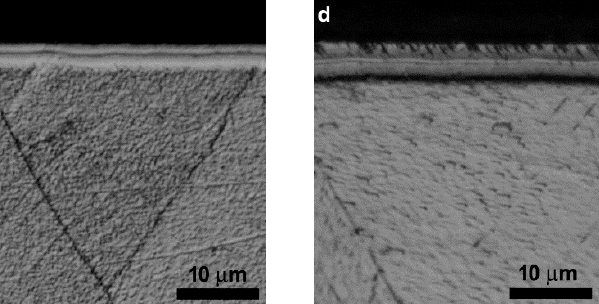
Figure 3. X-ray diffraction patterns of samples nitrided at 380 °C, for 3 h, using the following treat- ment atmospheres: 50 vol.% N 2 + 50 vol.% H 2 ( a ), 40 vol.% N 2 + 60 vol.% H 2 ( b ), 40 vol.% N 2 + 50 vol.% H 2 + 10 vol.% Ar ( c ), 30 vol.% N 2 + 50 vol.% H 2 + 20 vol.% Ar ( d ), 20 vol.% N 2 + 50 vol.% H 2 + 30 vol.% Ar ( e ). When nitriding was performed at 360 °C, with a gas mixture of 50 vol.% N 2 + 50 vol.% H 2 , the microstructure of the modified layers depended on treatment duration. Samples nitrided using durations from 1 to 3 h had an outer modified layer in which shear lines are hardly detectable (Figure 2b,c). When treatment duration was increased up to 5 h, many shear lines were delineated by chemical etching in the outer layer, and the micro- structure was comparable to that of 380 °C nitrided samples (Figure 2d). The thickness of the modified layers increased as the treatment duration was longer, due to nitrogen dif- fusion, with d o ranging from (1.1 ± 0.2) μ m (t = 1 h) to (2.3 ± 0.2) μ m (t = 5 h), and d i ranging from (1.3 ± 0.2) μ m (t = 1 h) to (1.7 ± 0.2) μ m (t = 5 h). In the XRD patterns (Figure 4), the peaks belonging to γ N shifted towards lower angles as treatment duration was longer, suggesting a lattice expansion due to higher nitrogen solubilization, while the peaks of γ (N,C) did not shift significantly. As observed for 380 °C nitrided samples, the asymmet- ric shape of the γ N peaks was well observable for the diffraction of the (2 0 0) plane, and for samples treated for 5 h the (2 0 0) peak tended to broaden markedly, with the overlap- ping of different peaks.